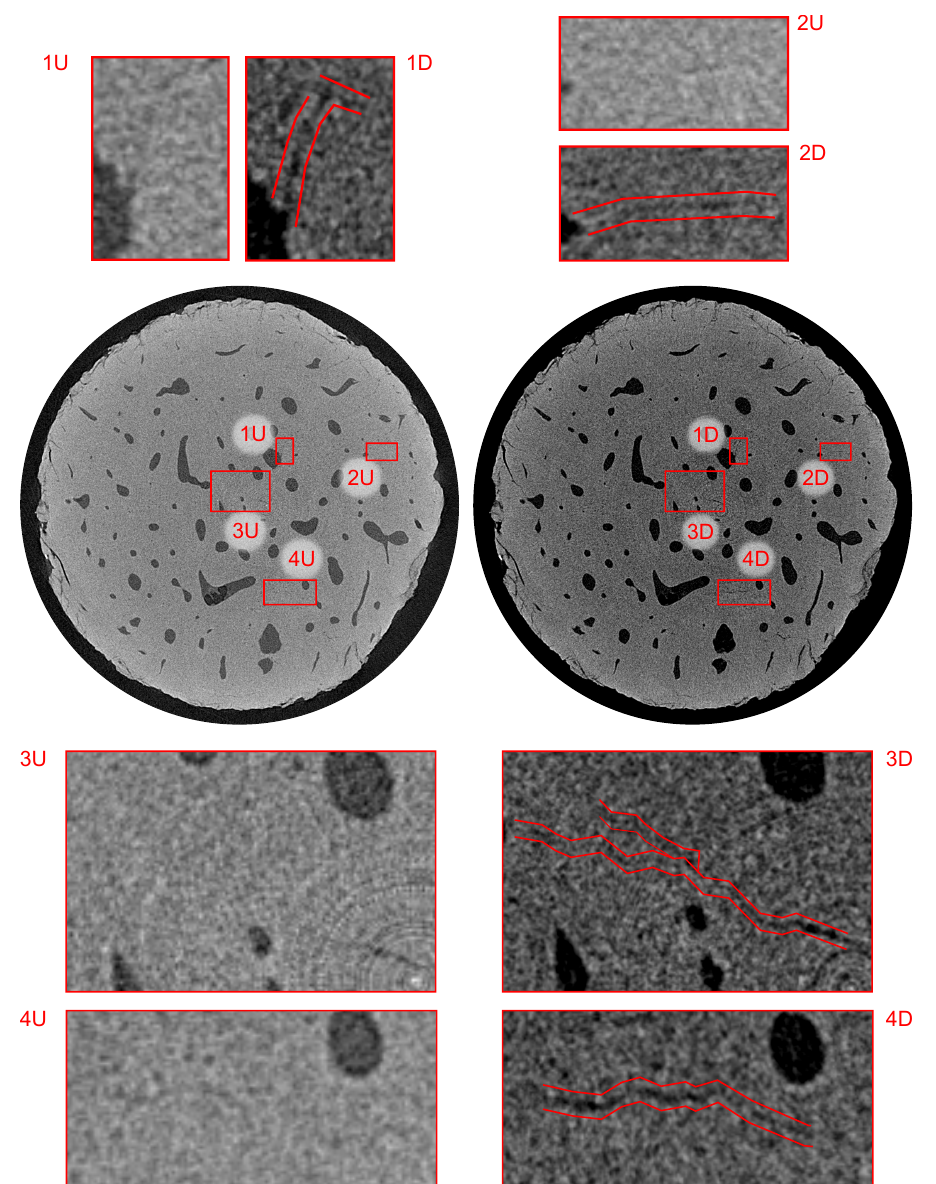
Figure 11. Visualization of the reconstructed 3D volumes—transverse plane at a distance of 1.76mm from the upper loading platen. Index “U” stands for the intact (unloaded) state and “D” stands for the loaded (damaged) state. The figure depicts, in red color, the microcracks with increased dimensions as a result of the loading